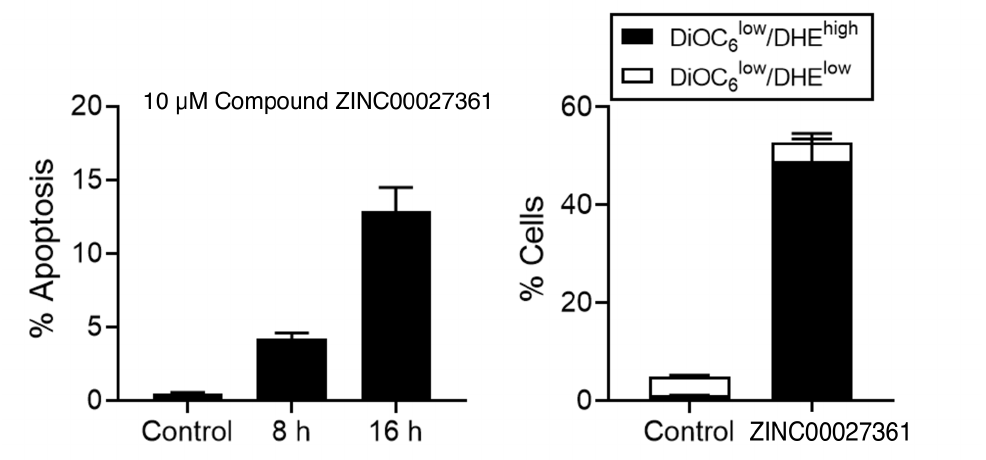
Figure 3. Time course of the GSK3 inhibitor (ZINC00027361) effect on parasites’ death. In the left side it is shown the cell cycle distribution of L. panamensis promastigotes based on the apoptosis percentage. Parasites were treated with 10 µ M of ZINC00027361 for the times indicated, stained with propidium iodide, and the proportion of parasites in each phase of the cell cycle was quantified by flow cytometry as described in Methods. Parasites in the Sub-G1 region (hypodiploidy) represent apoptotic-like parasites. Untreated control parasites were run in parallel. In the right side, L. pana- mensis promastigotes were untreated (control) or treated with 10 µ M inhibitor at 16 h, and parasites with disrupted ∆Ψ m (DiOC6(3) low and ROS production (DHE)) were measured by flow cytometry. Data are shown as means of three independent experiments with their standard